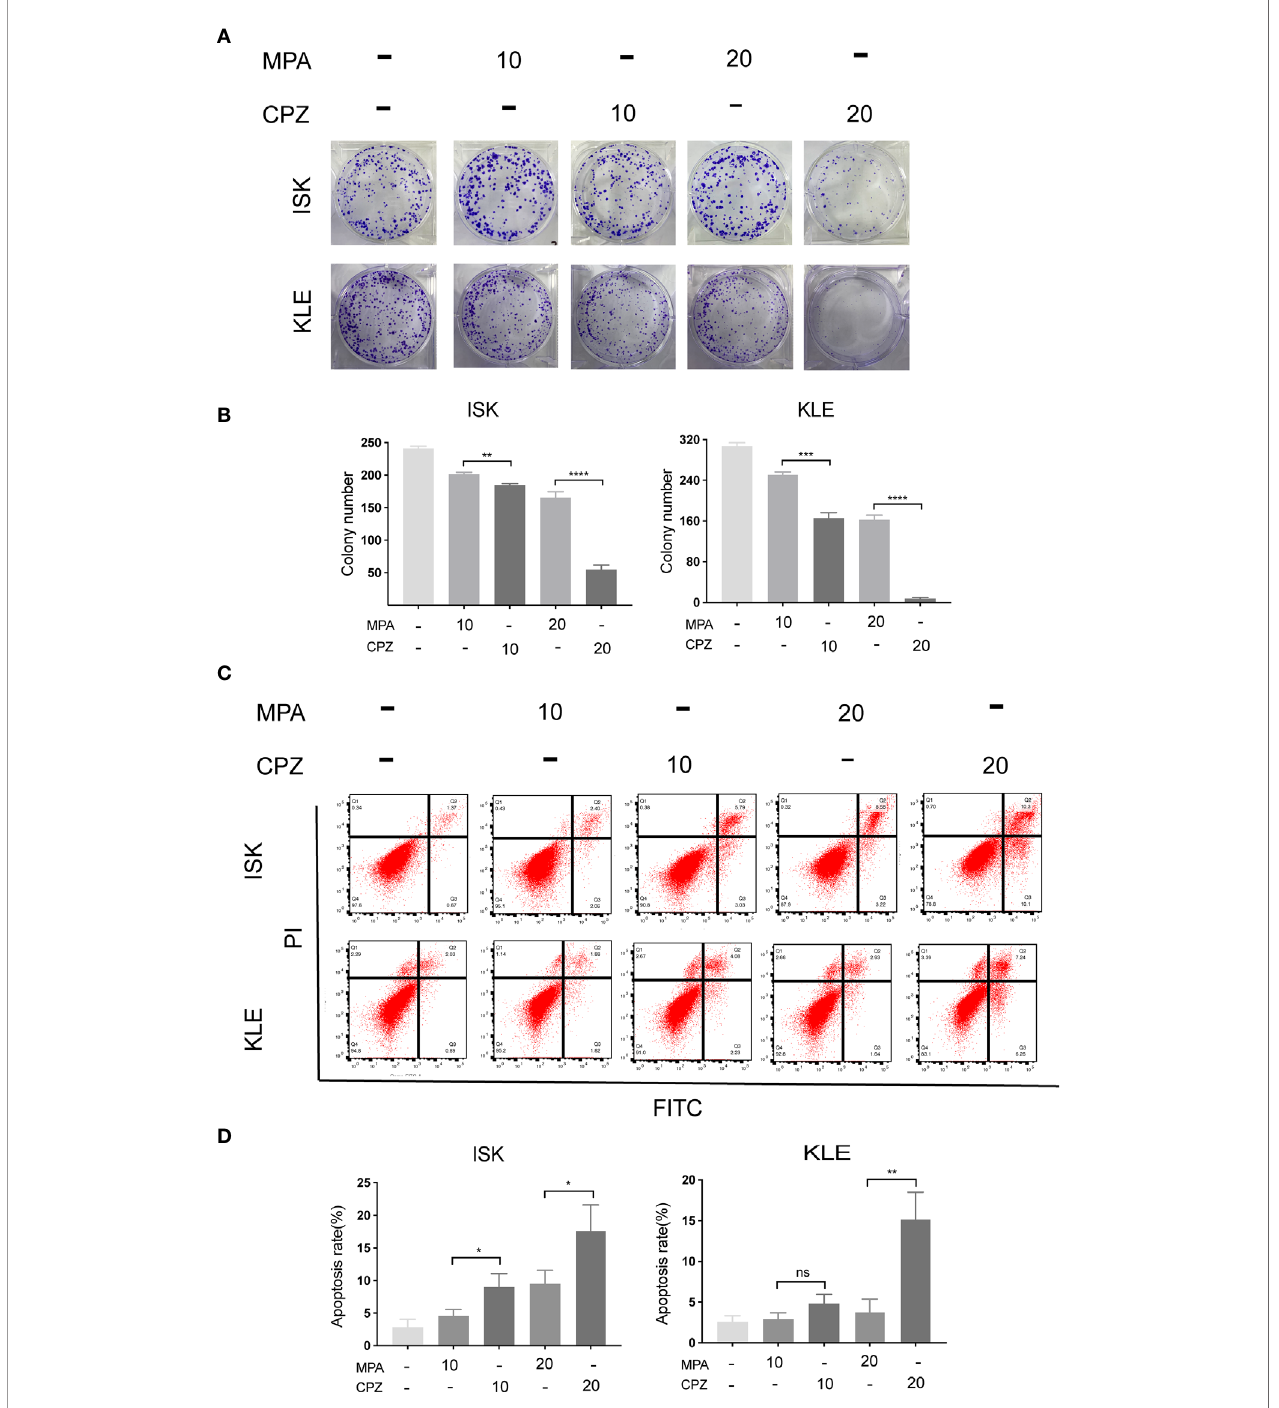
FIGURE 1 | CPZ inhibits proliferation and promotes apoptosis of EC cells. (A, B) Cells were incubated with MPA (10, 20 m M) or CPZ (10,20 m M) alone for 72 h. Colony formation assays were then utilized to evaluate the colony formation ability of EC cells in the presence of CPZ and MPA. (C, D) The rate of apoptosis was determined by fl ow cytometry. ISK and KLE cells were incubated with MPA (10, 20 m M) and CPZ (10,20 m M) for a total of 72 h. Q1 represents necrotic cells, Q2 represents cells in the late phases of apoptosis, Q3 represents cells in the early phases of apoptosis, and Q4 represents normal cells. Columns ± bars: IC 50 mean ± standard deviation. ns, not signi fi cant; *p < 0.05; ** p< 0.01; ***p < 0.001; ****p <